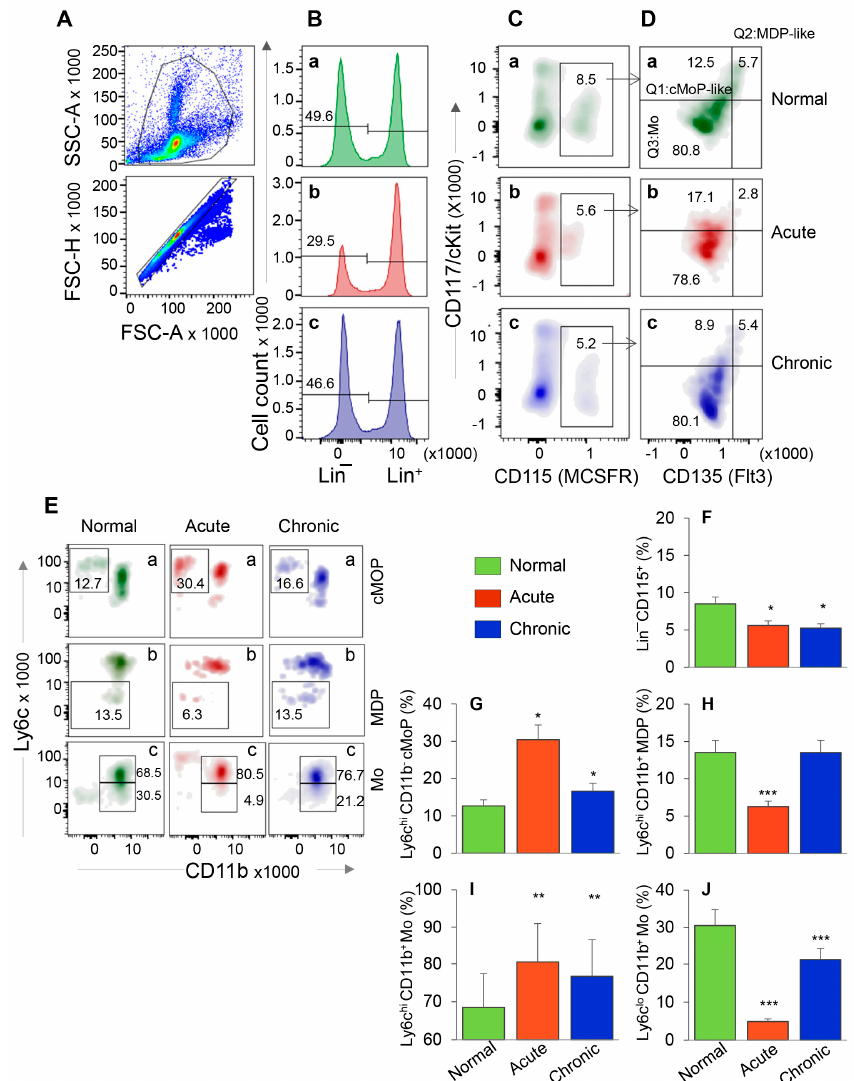
Figure 1. Bone marrow hematopoietic stem cell (HSC) monocyte progenitors’ response during T. cruzi infection and Chagas disease. C57BL / 6 mice were infected with T. cruzi (10,000 trypomastigotes per mouse, i.p.) and euthanized at 30 days and 150 days post-infection (pi) corresponding to acute infection phase and chronic heart disease phase, respectively. Single cell suspensions of bone marrow cells were stained with fluorescence conjugated antibodies and analyzed by flow cytometry. After gating the cells of interest in forward and side scatter area ( A , top panel), cells were further gated for forward scatter height to exclude doublets ( A , bottom panel). From these, Lin − HSCs ( B ) were gated for CD115 (MCSFR) in combination with CD117 (cKit) and CD135 (Flt3) ( C , D ). This gating resulted in identification of the frequencies of Lin − CD115 + monocyte progenitors (MoP) that exhibited CD117 + CD135 + Mo/DC progenitor (MDP) like, CD117 + CD135 − common MoP (cMoP) like, and CD117 − CD135 − Mo phenotypes. Each cell population from panel D was gated for CD11b to confirm their lineage and determine the proinflammatory (Ly6c hi ) and patrolling (Ly6c lo ) phenotype ( E ). Bar graphs show the mean percentages of MoPs ( F ), cMOPs ( G ), MDPs ( H ), and monocytes that were of Ly6c hi ( I ) and Ly6c lo ( J ) phenotype in acute and chronic (vs. normal) mice. Data are representative of two independent experiments ( n = 4 mice per group per experiment, 2–3 evaluations per sample) and plotted as mean value ± SEM. Significance is annotated as * Tc -infected vs. non-infected. * p value < 0.05; ** p value < 0.01; and *** p value <